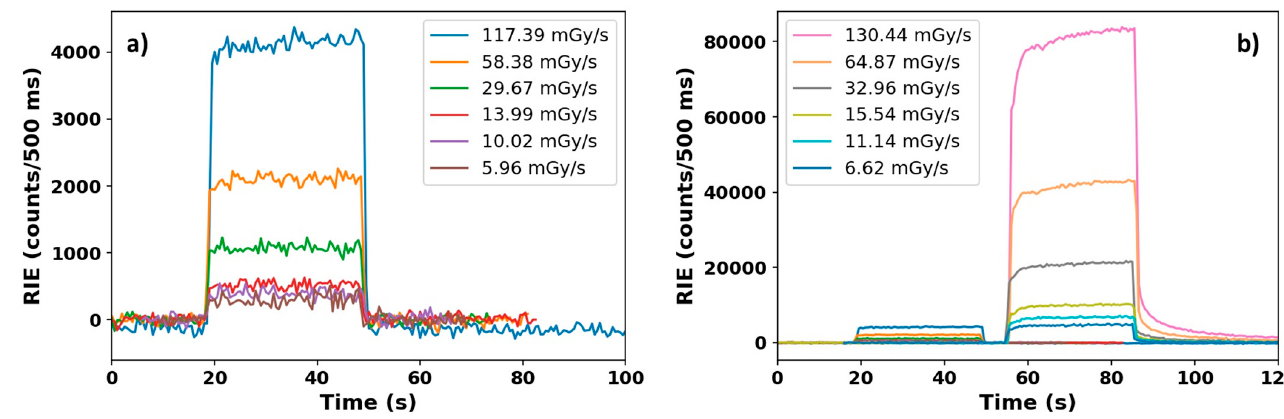
Figure 7. ( a ) RHF fiber RIE intensity. ( b ) RHF + Ce ‐ doped fiber RIE intensity during several quasi ‐ continuous X ‐ ray irradiations at six different dose rates.